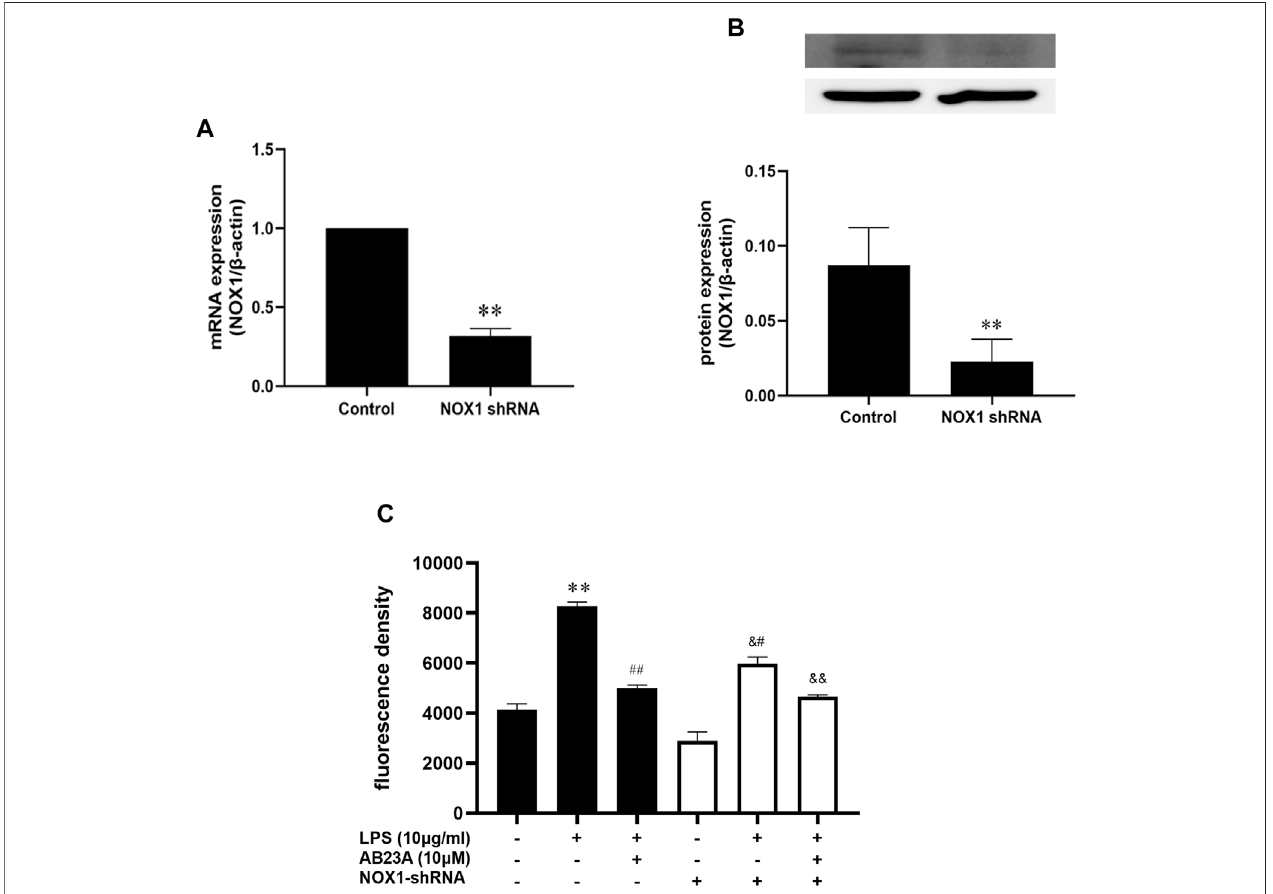
FIGURE7| AB23A effects onthe ROSgenerationinducedby LPSin TLR4-shRNA transfectedcells. (A) TheNOX1mRNA expression level. (B) The NOX1 protein expressionlevel. (C) AB23AeffectsontheROSgenerationinducedbyLPSinNOX1knockdowncells.** p < 0.01vs.control; ## p < 0.01vs.LPS(10 μ g/ml); &# p < 0.01vs. NOX1-shRNA; && p < 0.01 vs. NOX1-shRNA + LPS (10 μ g/ml).